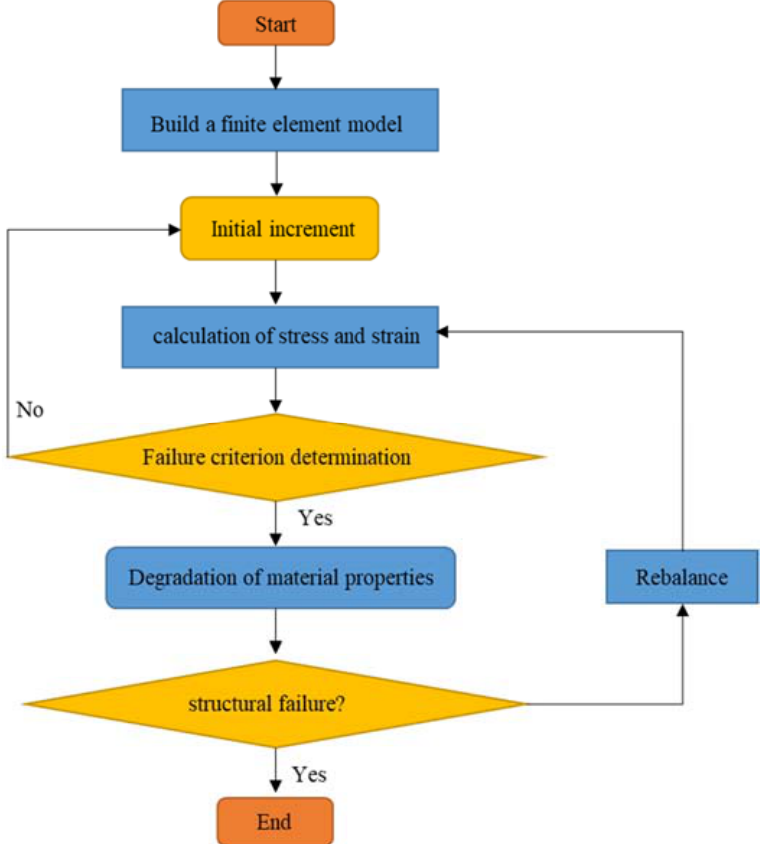
Figure 2. Progressive damage analysis process.